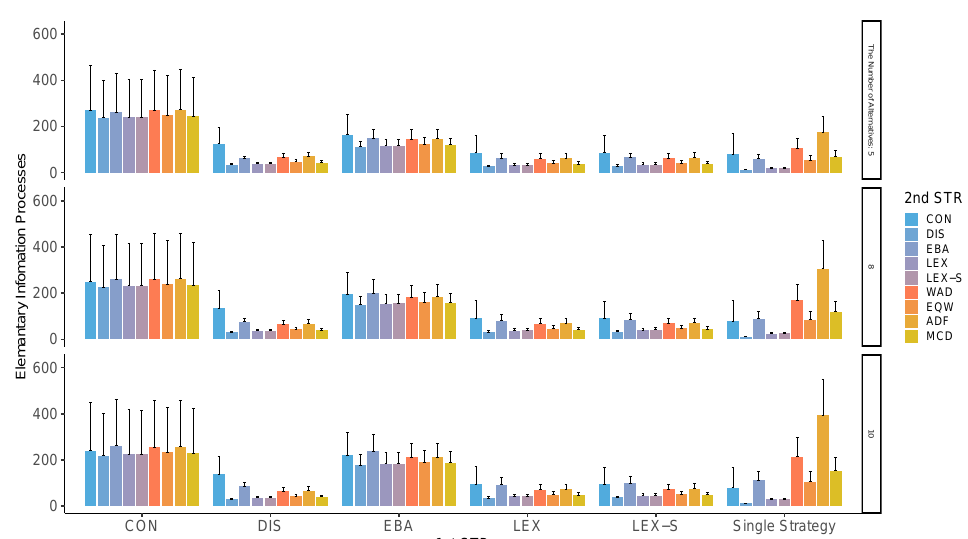
Figure A17. Average EIPs in two-stage decision-making when only two alternatives are left in the second stage. Note: ADF: additive difference; CON: conjunctive; DIS: disjunctive; EBA: elimination by aspects; EQW: equal-weighted strategy; LEX: lexicographic; LEX-S: lexicographic semi-order; MCD: majority of confirming dimensions; STR: strategy; WAD: weighted additive.